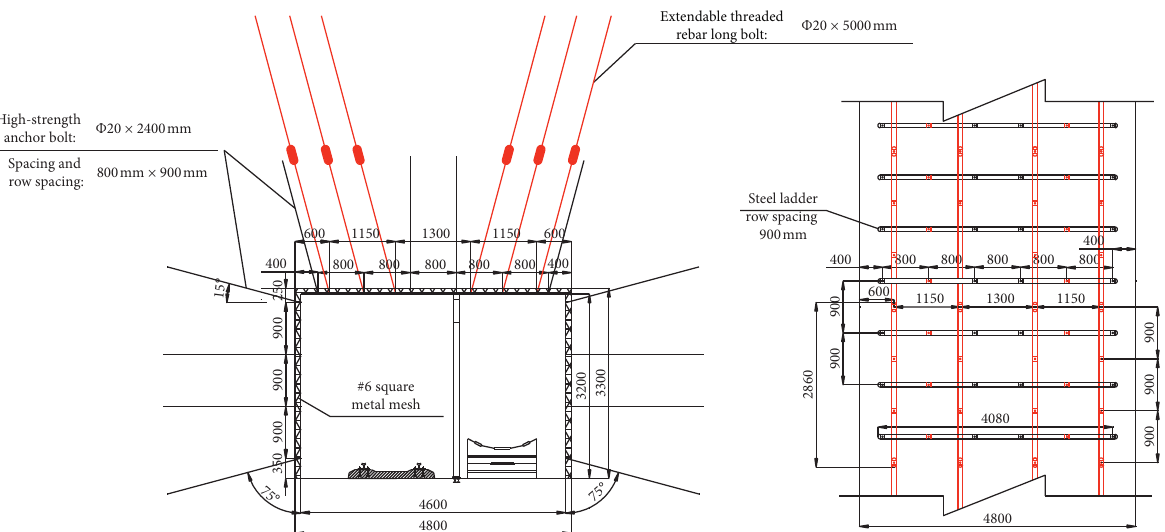
Figure 16: Support design for roof with grade II risk in the intake airway of working face 11030 of the mine.